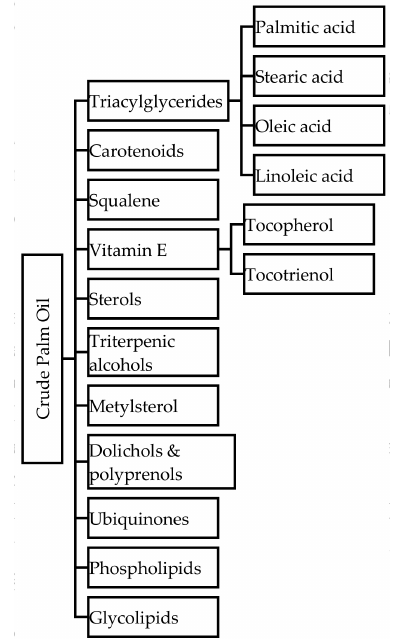
Figure 2. Crude palm oil (CPO)